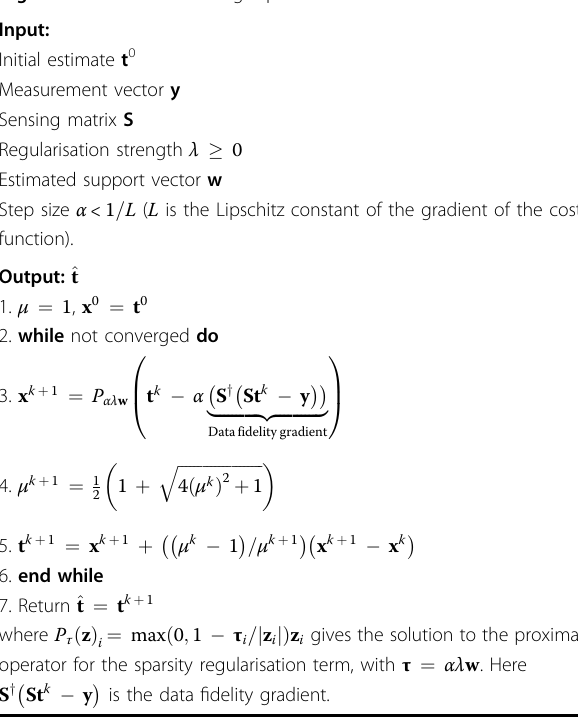
Table 1 Pseudo-code describing the algorithm used to solve Eq. 2. Algorithm 1 FISTA for solving Eq.